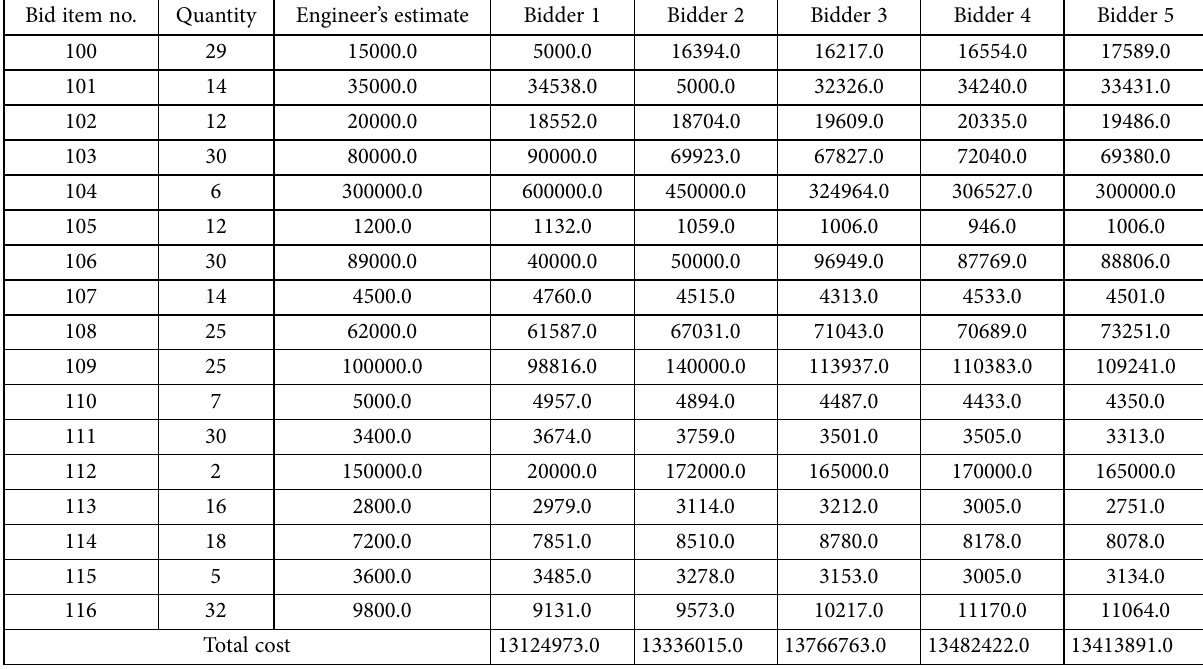
Table 1. Quotation data of the project